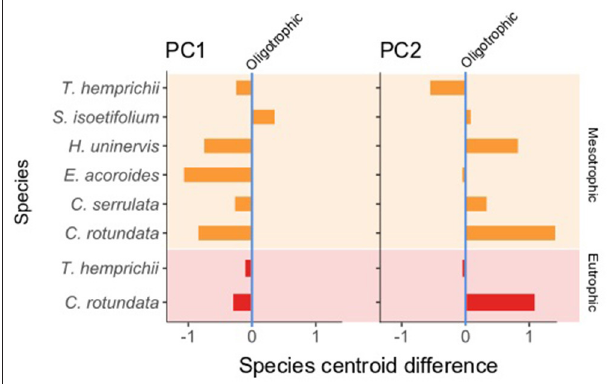
FIGURE 7 | Difference in the species centroids from the oligotrophic (vertical zero axis) to the mesotrophic (orange bar, light orange background) and eutrophic (red bars, light red background) states. T. ciliatum and H. ovalis are not present in these plots due to their presence uniquely under a single trophic state, oligotrophic and mesotrophic, respectively. For the differences in species centroids in the rest of the PCs see Supplementary Material 7